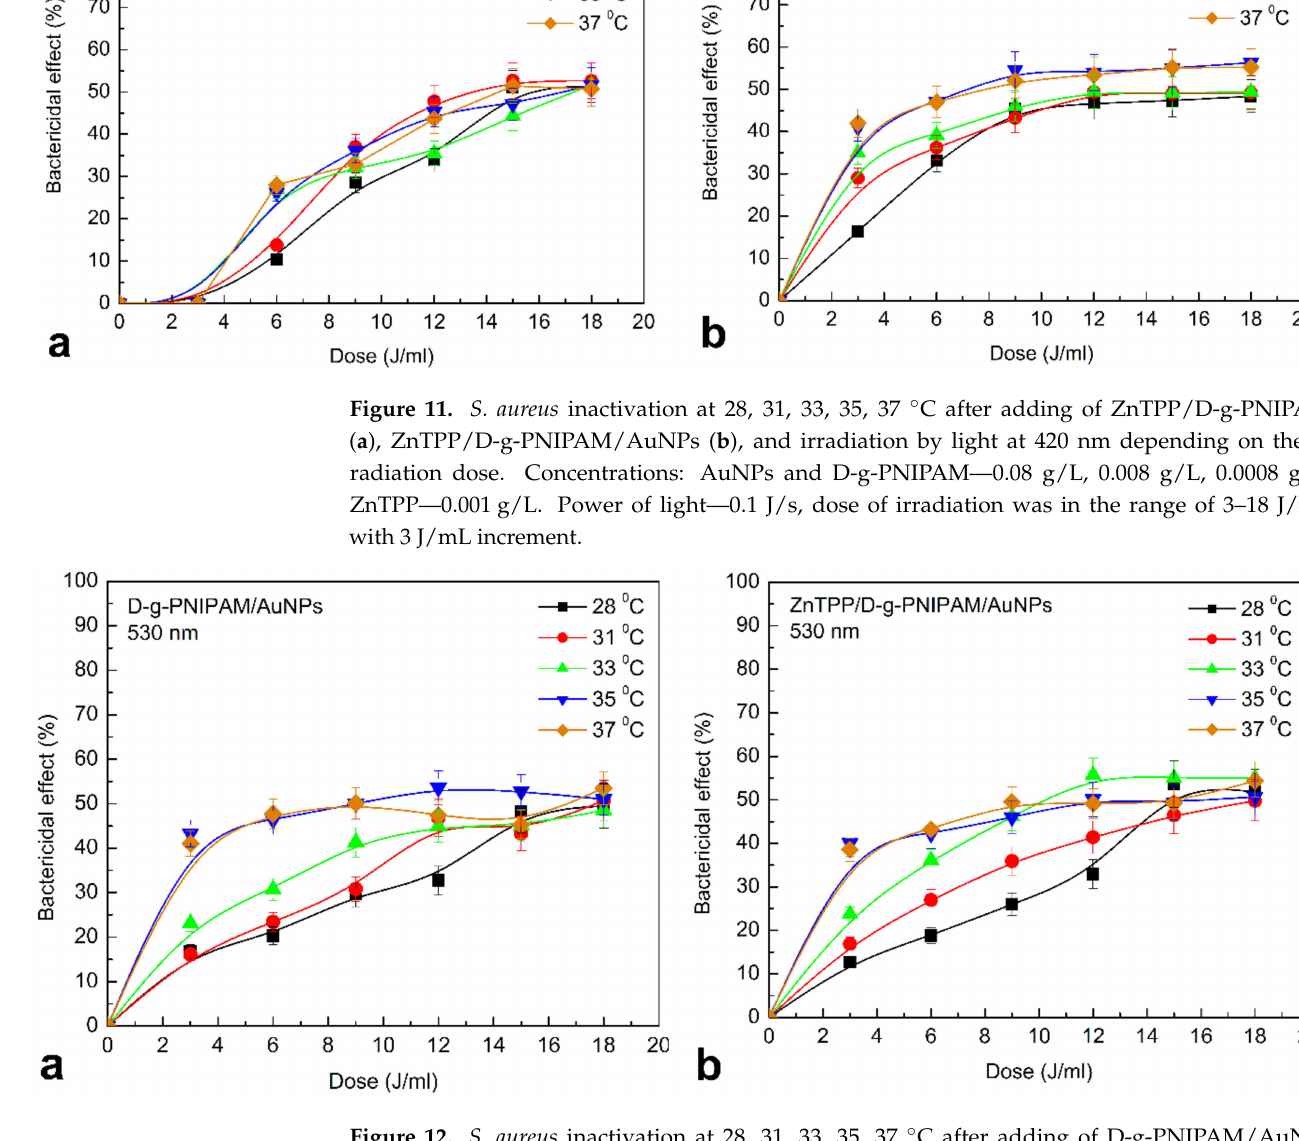
Figure 12. S. aureus inactivation at 28, 31, 33, 35, 37 ◦ C after adding of D-g-PNIPAM/AuNPs ( a ), ZnTPP/D-g-PNIPAM/AuNPs ( b ), and irradiation by light at 530 nm depending on the ir- radiation dose. Concentrations: AuNPs and D-g-PNIPAM—0.08 g/L, 0.008 g/L, 0.0008 g/L, ZnTPP—0.001 g/L. Power of light—0.1 J/s, dose of irradiation was in the range of 3–18 J/mL with 3 J/mL